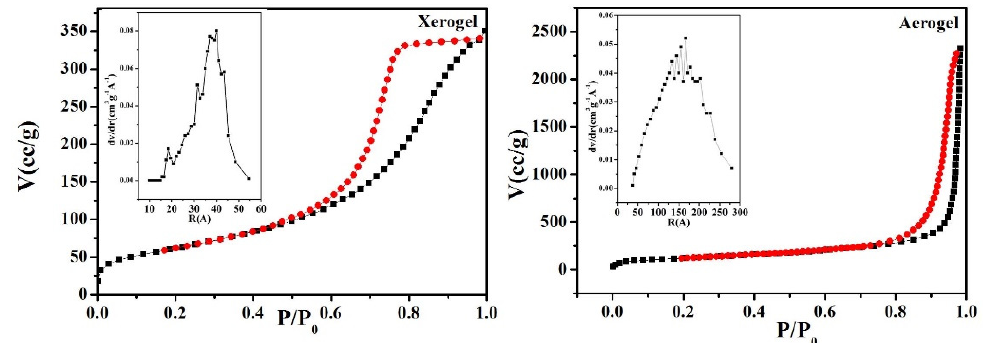
Figure 3. N 2 adsorption–desorption isotherms and pore size distribution of the composite aerogel and xerogel; black square represent adsorption, red dot represent desorption.